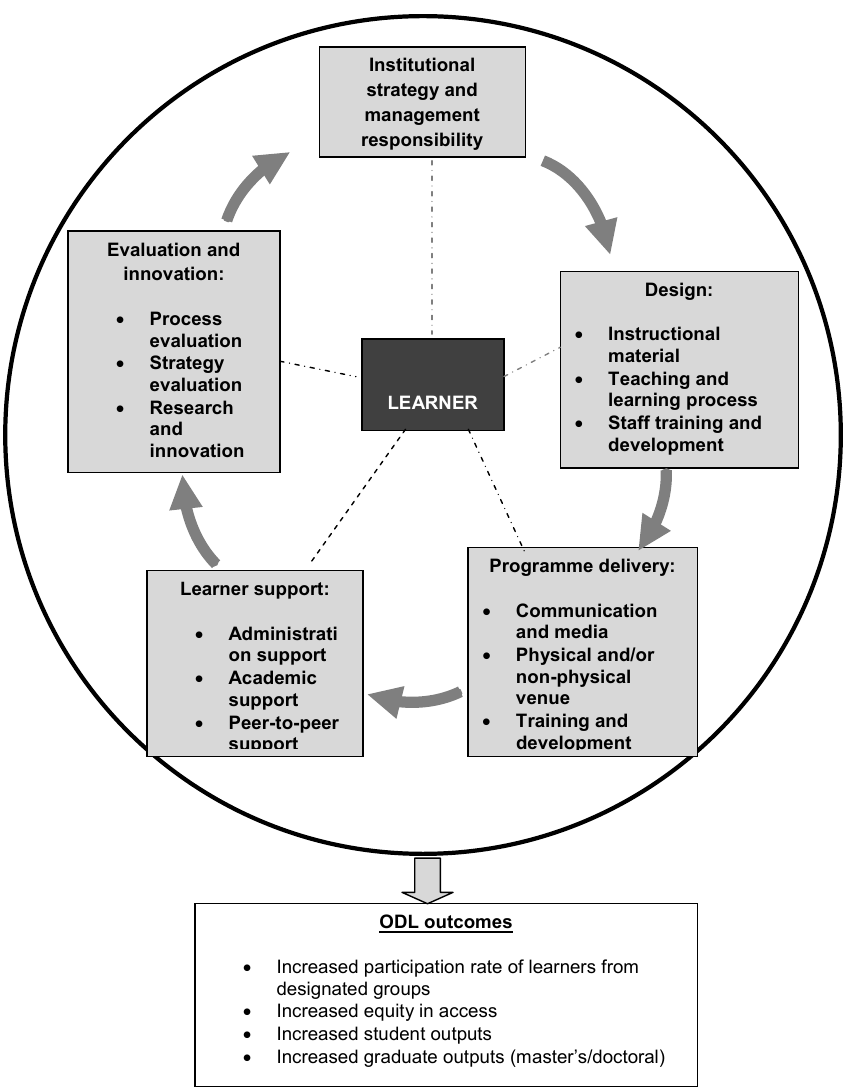
Figure 2 . An illustration of a typical ODL system with its corresponding outcomes.